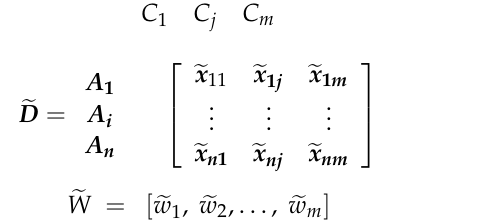
.. R ). The normalized matrix (